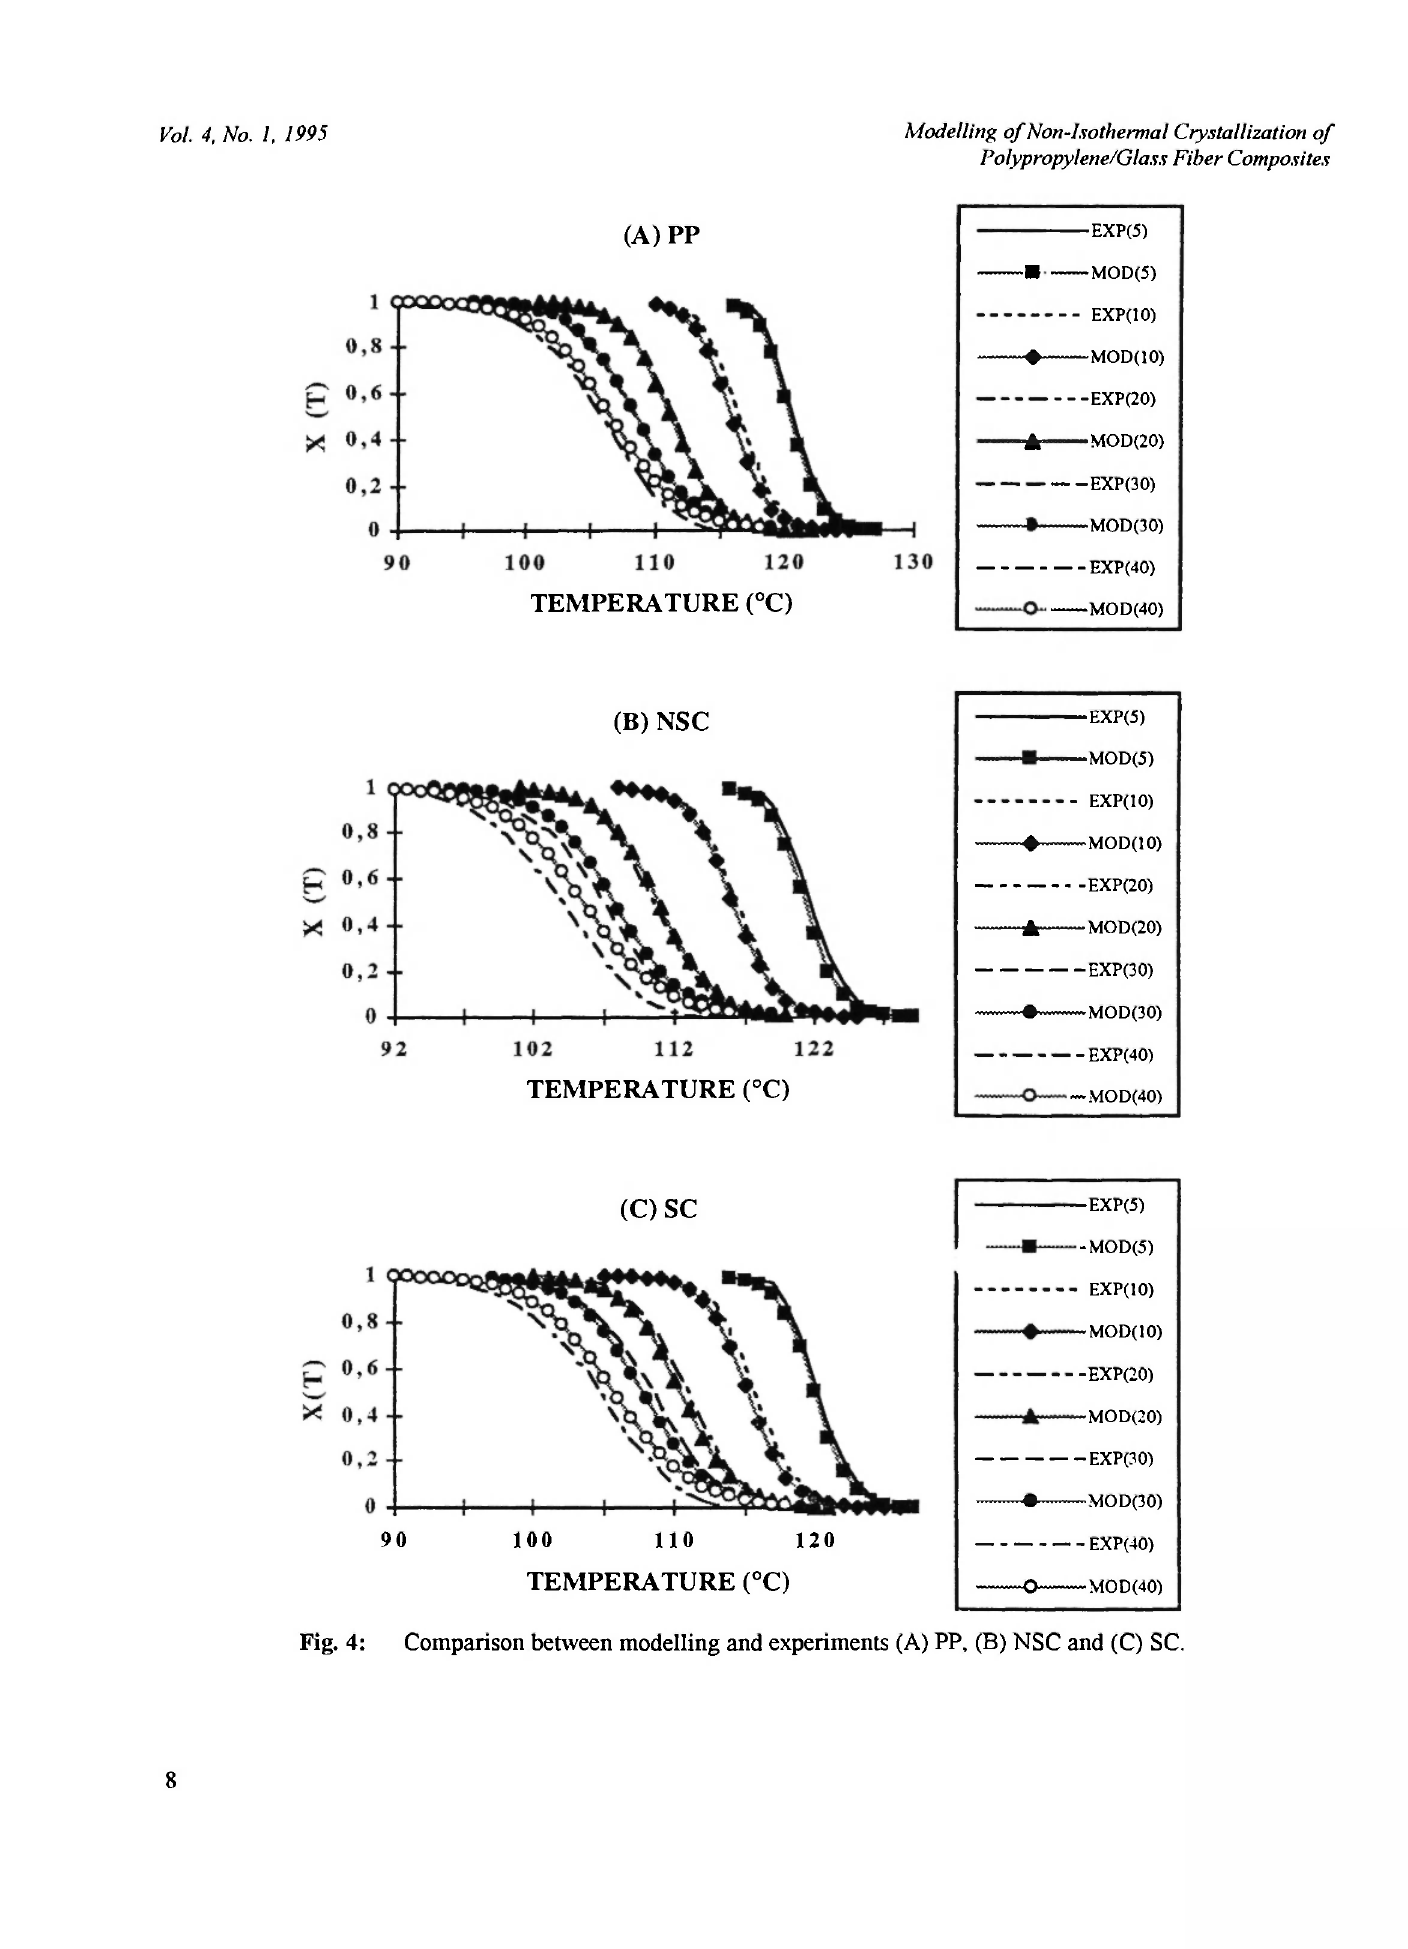
Fig. 4: Comparison between modelling and experiments (A) PP, (B) NSC and (C)